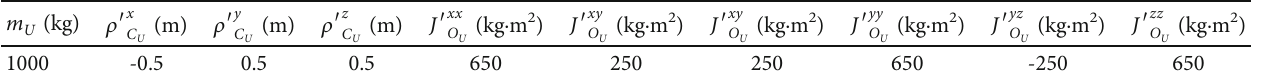
Figure 11: Initial con fi guration of space robot and noncooperative satellite: (a) whole system; (b) end e ff ector. Table 2: Inertia parameters of the unknown